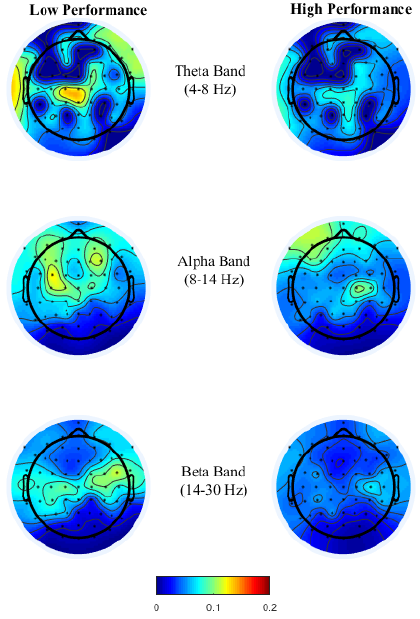
Figure 5. Scalp activities across EEG channels from non-zero LASSO coefficients from brain spectral power for low- and high-typing task performance.